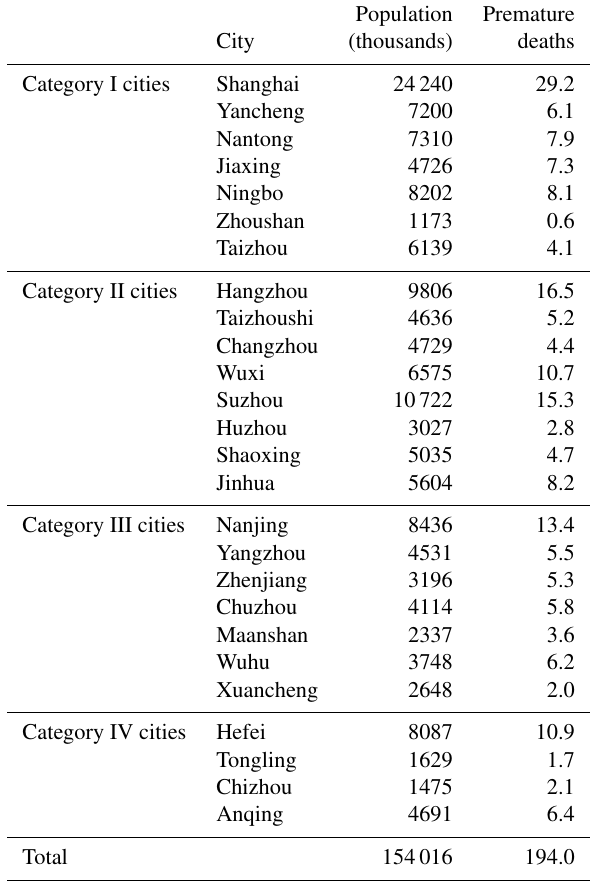
Table 4. Premature deaths through respiratory disease induced by O 3